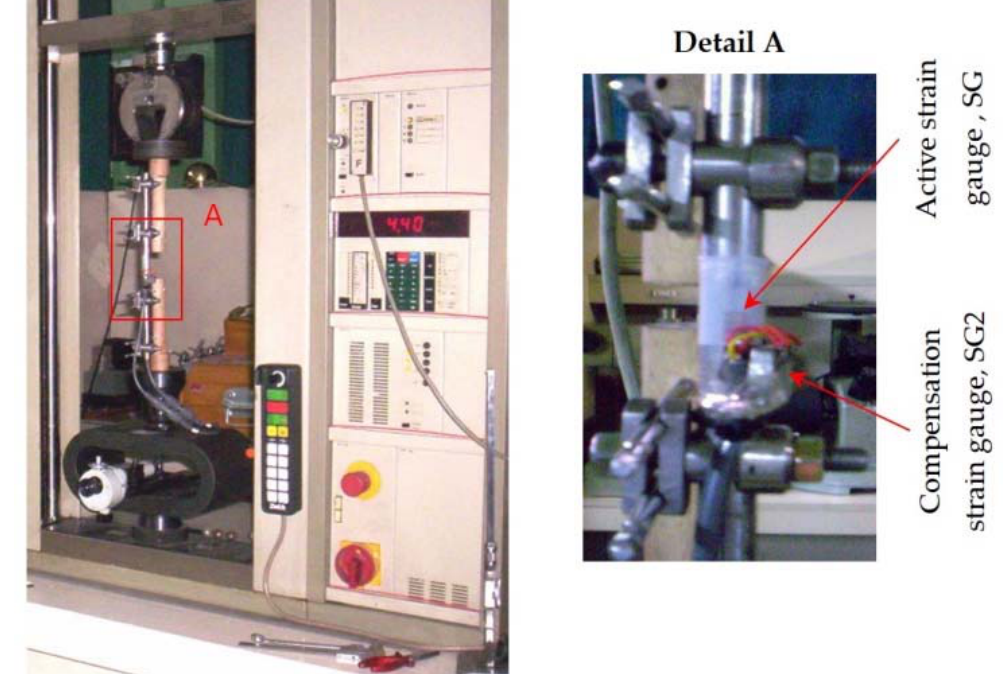
Figure 7. Experimental analysis of external fixation device for axial pressure load.